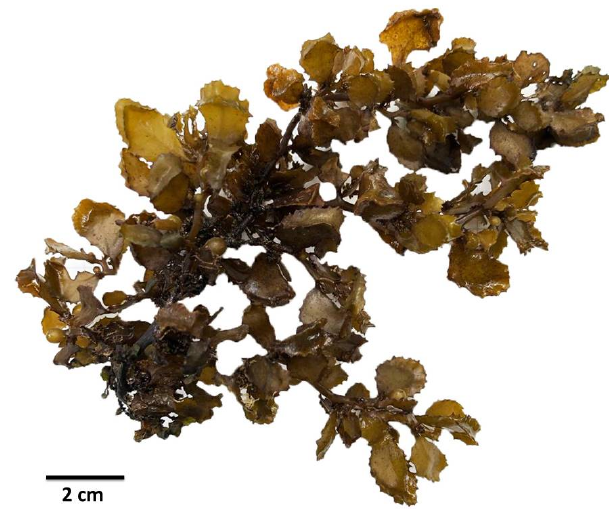
Figure 1. Brown macroalgae Sargassum cristaefolium .